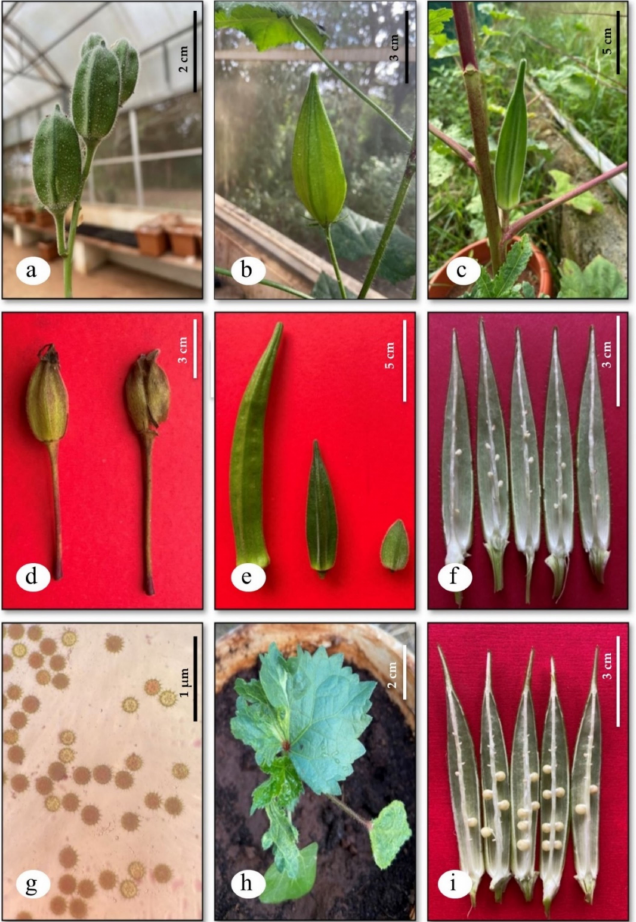
Figure 1. Fruits of A. ficulens ( a ), A. moschatus ( b ), A. esculentus × A. ficulens F 1 ( c ), immature fruit drop in the cross A. moschatus × A. esculentus ( d ), fruits of A. esculentus cv. ‘Arka Anamika’, F 1 between A. esculentus × A. manihot and A. manihot , respectively ( e ) , sterile fruits with no seed set in F 1 of the cross A. esculents × A. manihot ( f ), fertile and sterile pollen in F 1 of the cross A. esculentus × A. moschatus ( g ), malformation of leaves in colchicine treated interspecific F 1 ( h ), partial seed set in colchicine treated F 1 of cross A. esculentus × A. manihot ( i